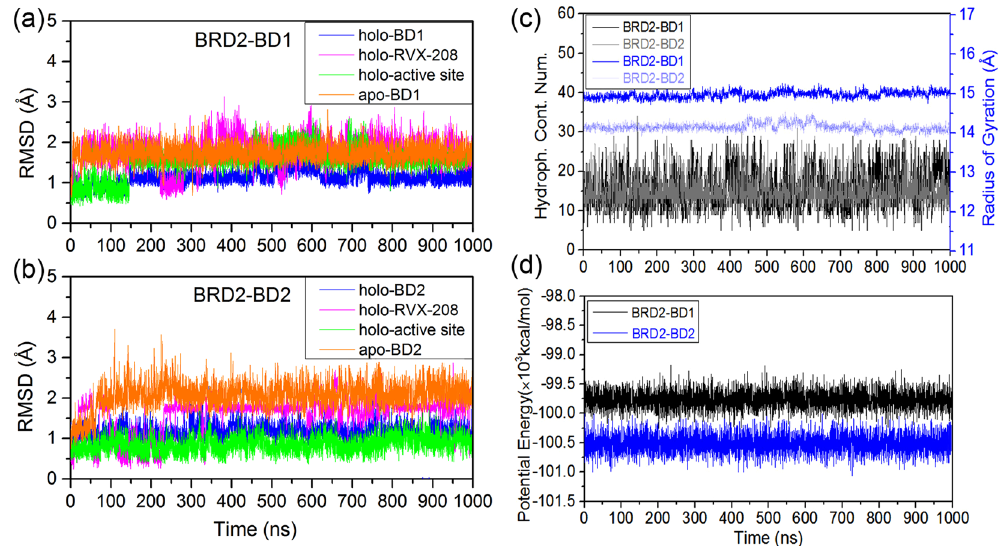
Figure 2. Time series of RMSDs of p-rotein, RVX-208 and active site in holo and apo systems of ( a ) BRD2-BD1 and ( b ) BRD2-BD2; time series of ( c , left) contact number between CA atoms of hydrophobic residues of BDs and RVX-208, (c, right) radius of gyration of BDs and ( d ) potential energy in two complex